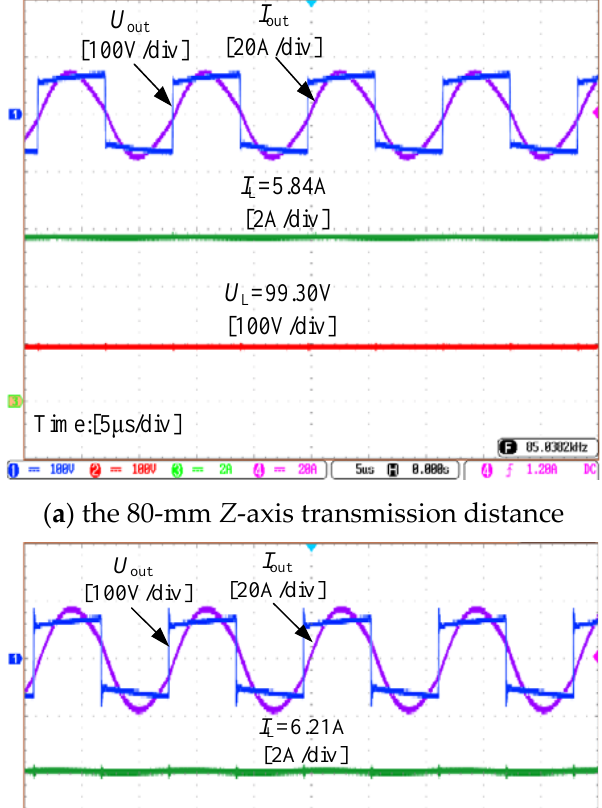
Figure 12. Experimental waveforms of U out , I out , U L , and I L for full load with R L = 17 Ω .